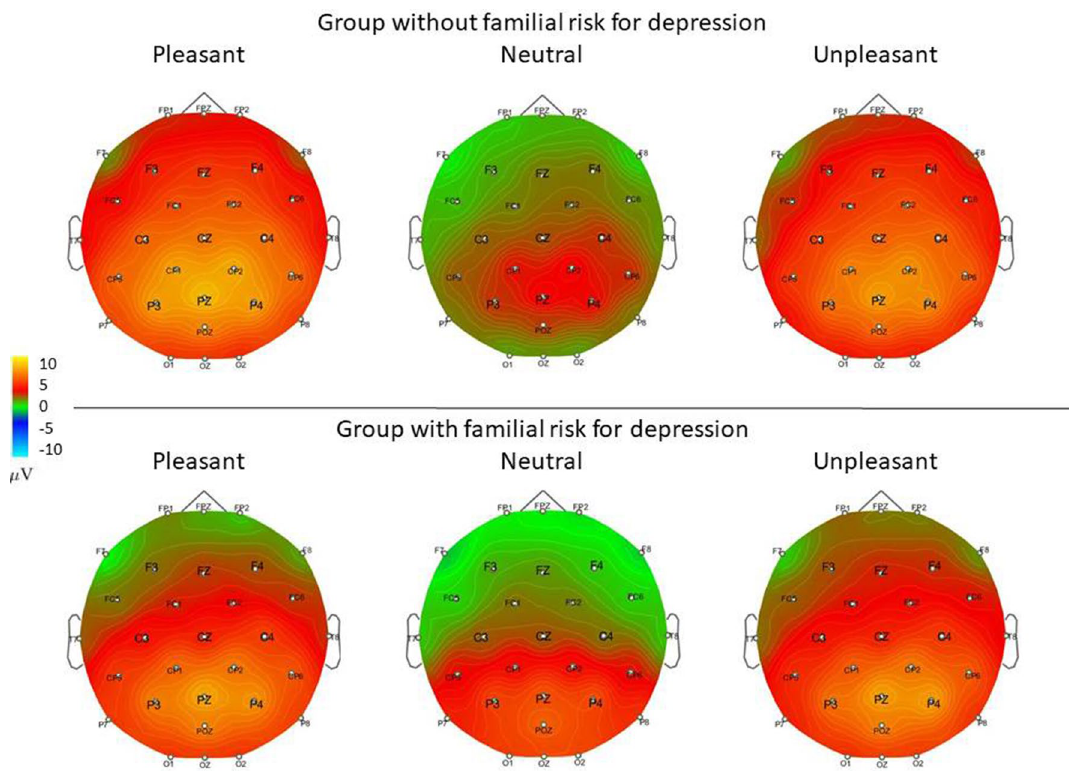
Figure 2. Scalp topography of pleasant, neutral, and unpleasant pictures in P300-LPP complex (400–600 ms) in the group with and without familial risk for depression.